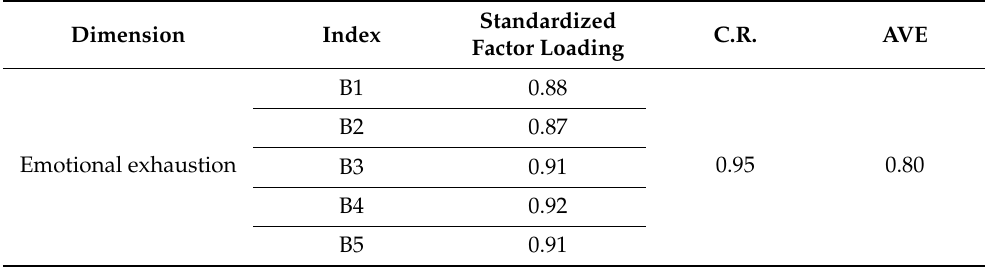
Table 4. Summary of Convergent Validity and Dimension Reliability-Emotional Exhaustion.